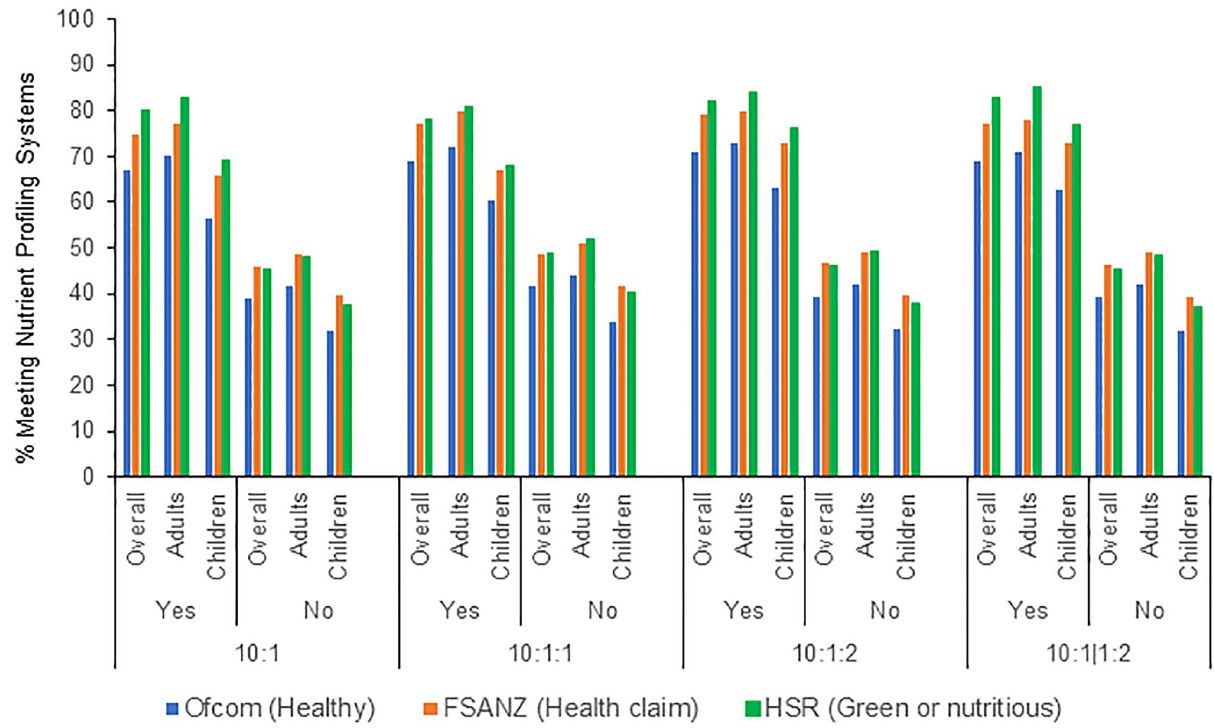
Fig 1. Comparisons of consumed carbohydrate-rich products meeting each of the three nutrient profiling systems classified as either meeting or not meeting each of the four proposed metrics. These four different carb metrics were based on, per 10g of carb:(a) � 1g fiber (10:1 carb:fiber), (b) � 1g fiber and < 1g free sugars (10:1:1 carb:fiber:free sugars), (c) � 1g fiber and < 2g free sugars (10:1:2 carb:fiber:free sugars); and (d) � 1g fiber and, per each 1 g of fiber, < 2g free sugars (10:1 carb:fiber, 1:2 fiber:free sugars; or 10:1|1:2). Children included individuals aged 2–19 years old and adults included individuals aged 20 years and older. Ofcom model was developed for the regulation of television advertising to children in the United Kingdom. Foods with a final score of < 4 points and beverages scoring < 1 point are considered as healthy. The FSANZ (Food Standards Australia New Zealand) model was developed for the regulation of health claims on foods in Australia and New Zealand. Foods with a final score of < 4 points and beverages scoring < 1 point are meeting score criteria to carry a health claim. The HSR (Health Star Rating) is a government led initiative that scores the nutritional value of packaged foods. It is designed to help consumers make healthier choices when shopping within a category. The score of HSR ranges from ½ star to 5 starts. Foods and beverages with a final score of 3.5 points or more is considered as green or